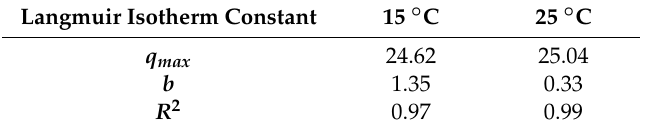
Table 5. Adsorption isotherm parameter obtained from adsorption of MB dye at surface of LNT4 NPs.